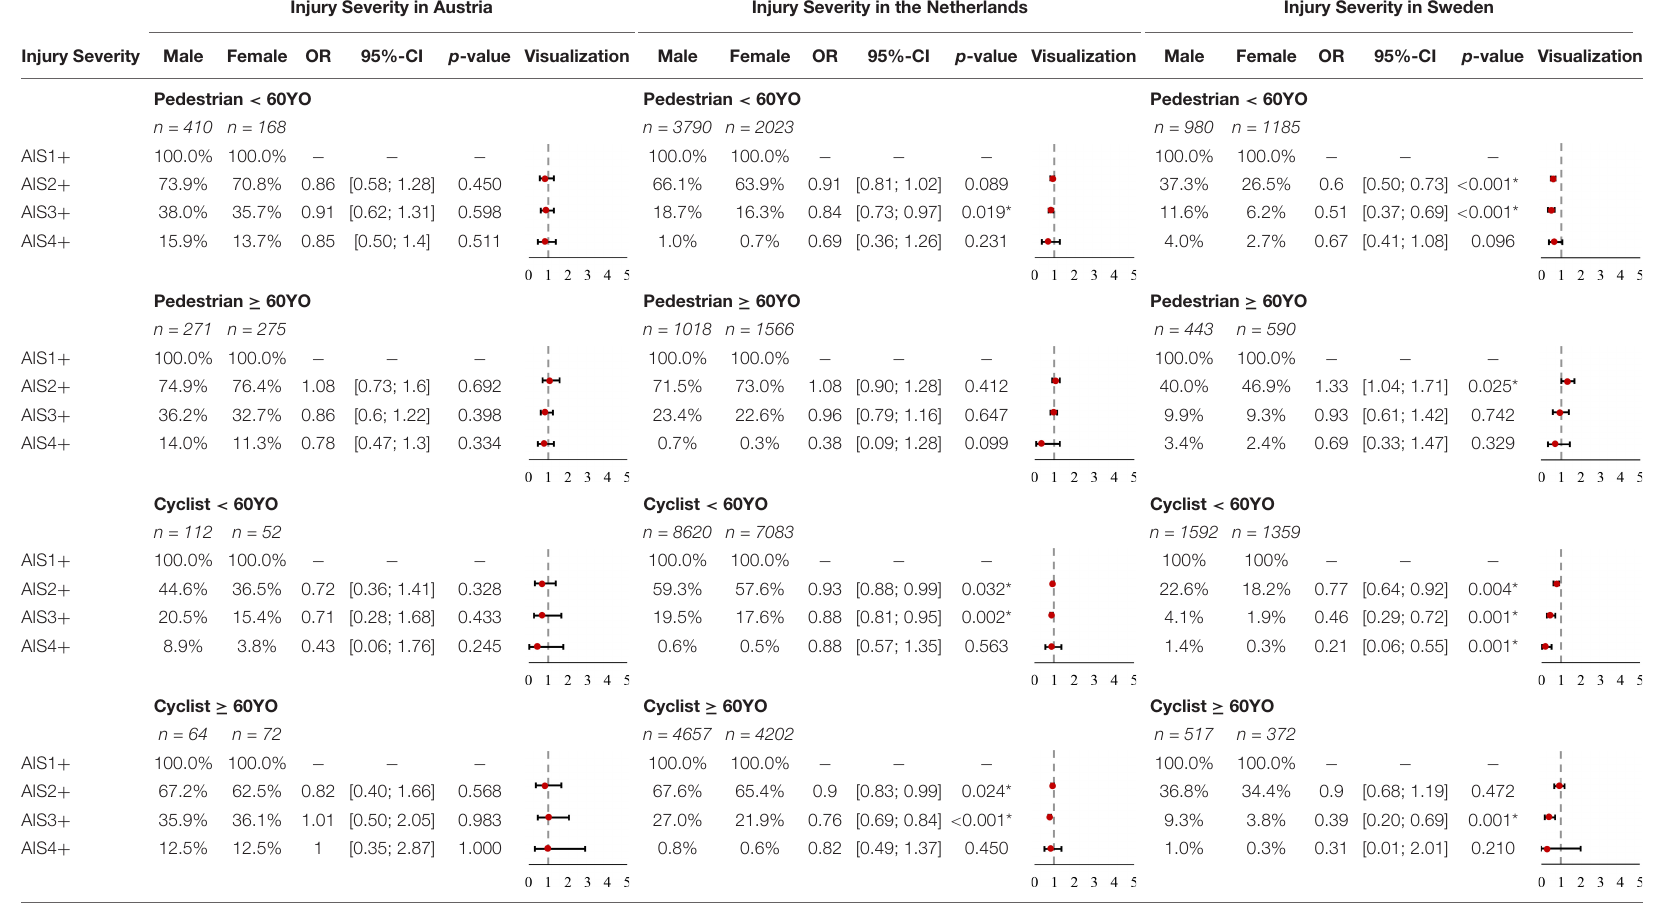
TABLE 10 | Injury Severity, OR and p -value for pedestrians and cyclists < 60YO and ≥ 60YO in Austrian, Dutch, and Swedish accident data (* p -value < 5%). Injury Severity in Austria Injury Severity in the Netherlands Injury Severity in